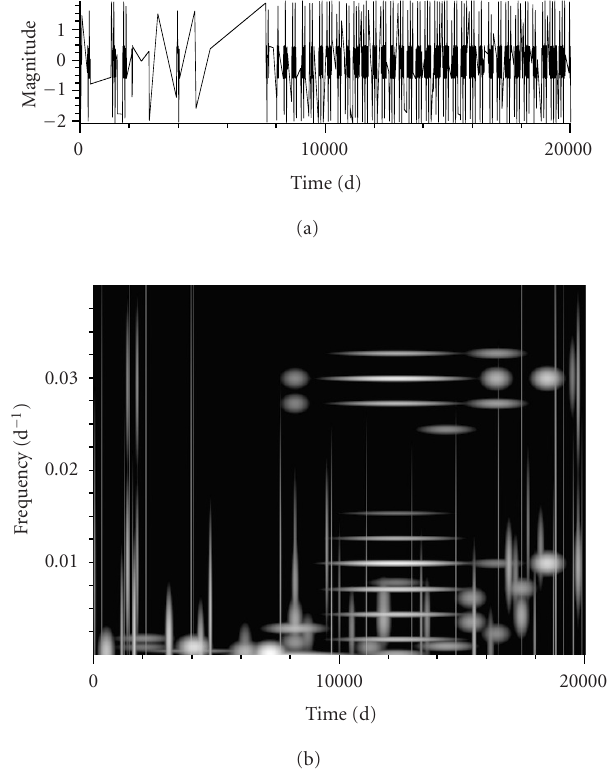
Figure 12: Time-frequency decomposition (b) of the simulated sig- nal (a) made from the RV Tauri sampling. Each grey level represents the energy density of each atom.